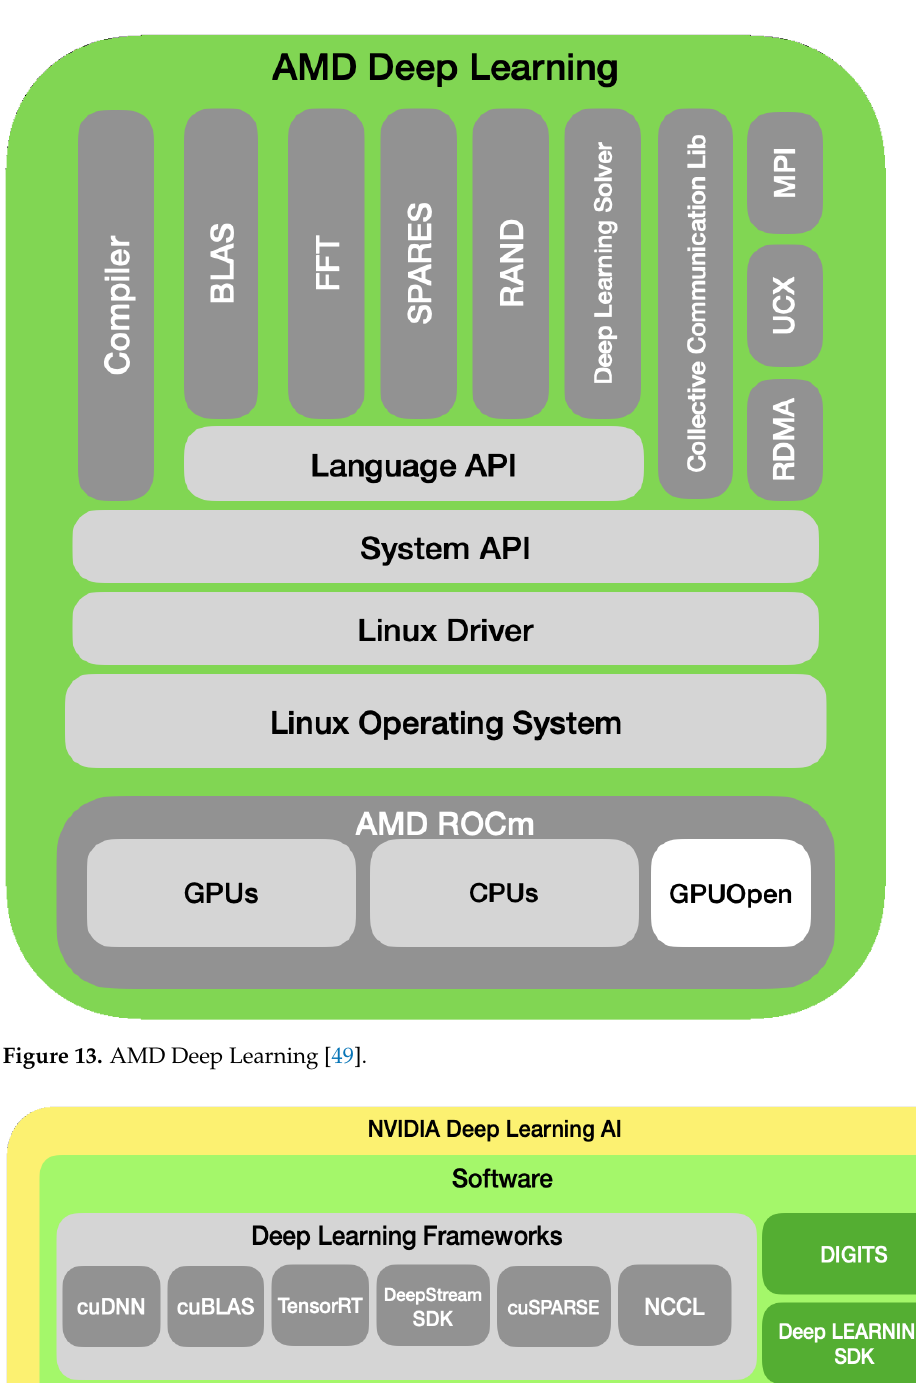
Figure 14. nVIDIA deep learning AI